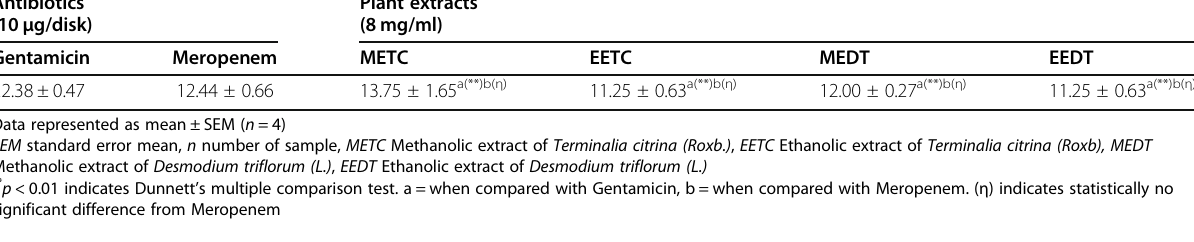
significant difference from